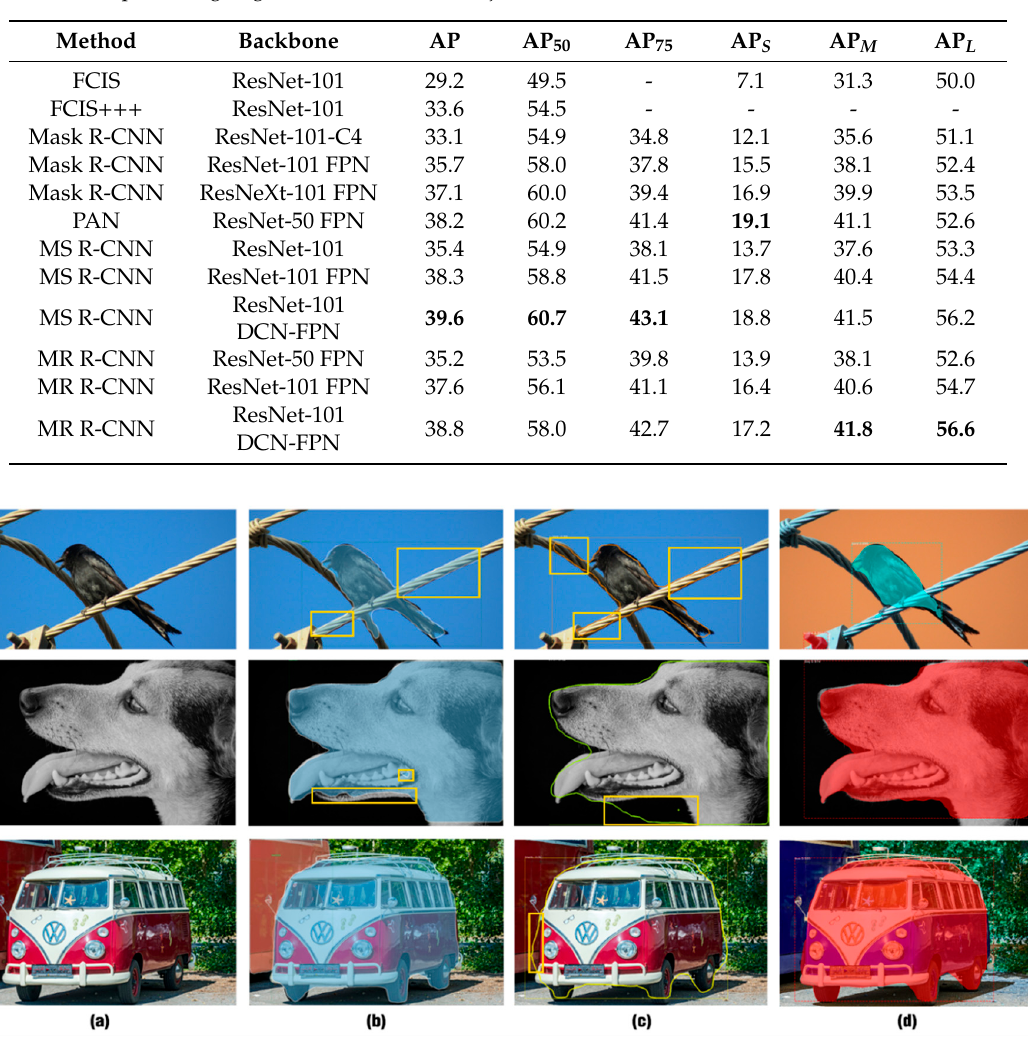
Table 2. Instance segmentation mask on COCO (Common Objects in Context) test-dev. FCIS was the winner of COCO 2016. FCIS +++ uses more mature technology. Mask R-CNN’s network segmentation accuracy has been substantially improved, and it is the benchmark for the 2017 segmentation network model. PAN, proposed in 2018, yielded excellent results; however, the network is complex, the amount of data is large, and it requires more time. MS R-CNN in 2019 yielded the best results. MR R-CNN is suitable for predicting large and medium-sized objects, while other indicators are close to the best value.